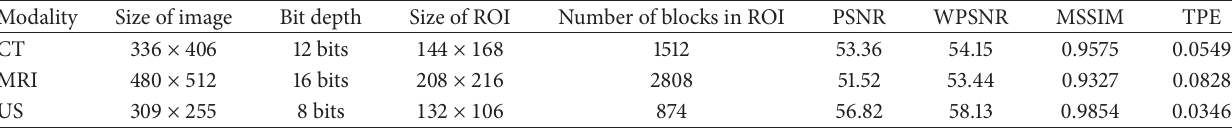
Table 3: Results of embedding data in three medical images of different modalities.